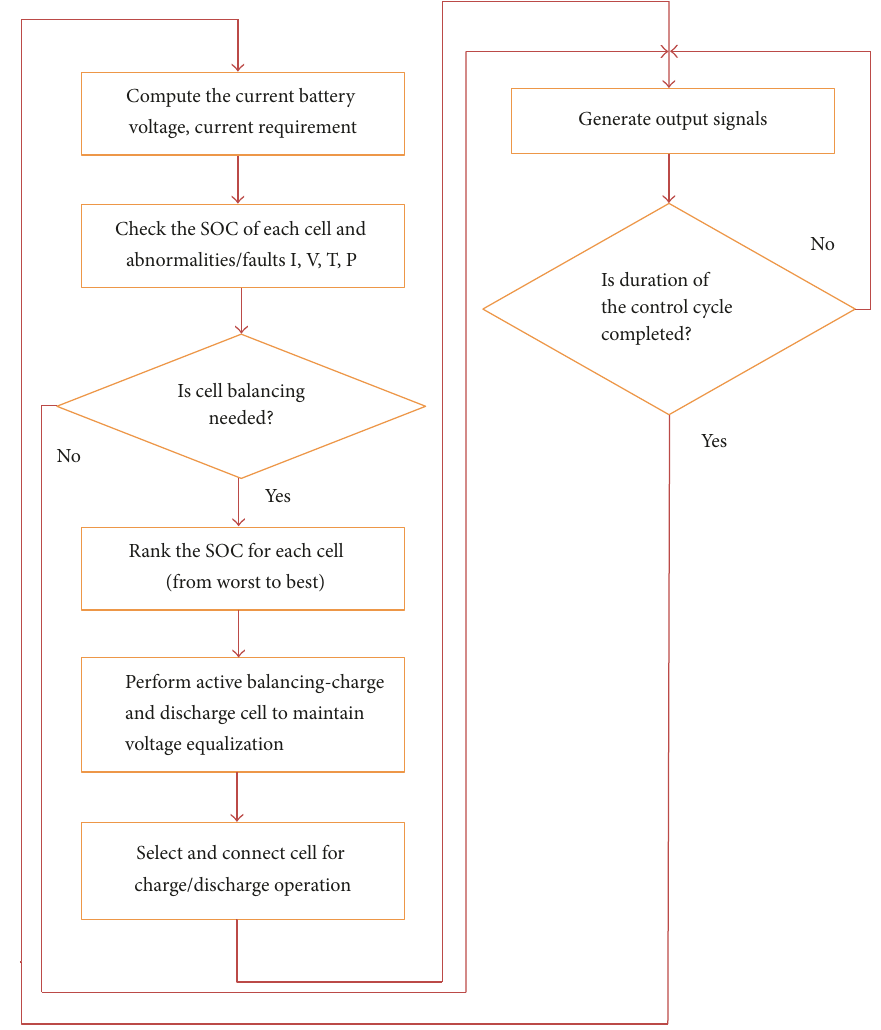
Figure 4: Active cell balancing algorithm flowchart.